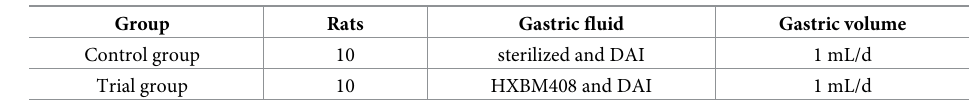
Table 1. Test group